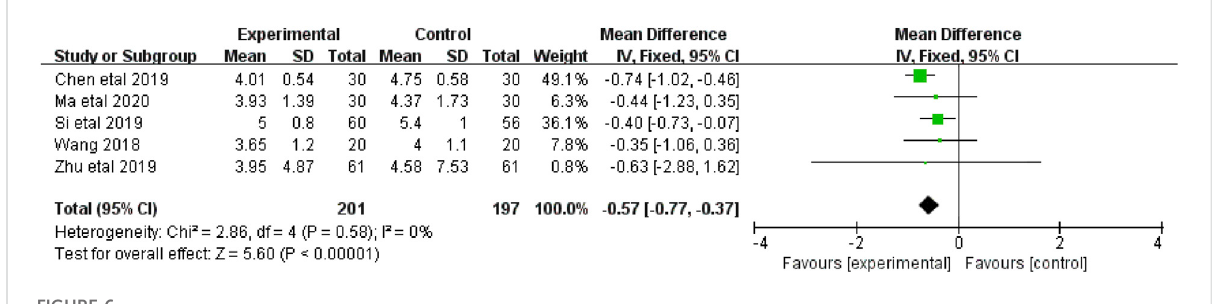
FIGURE 6 The forest plot of sensory subscales of PFS scores.